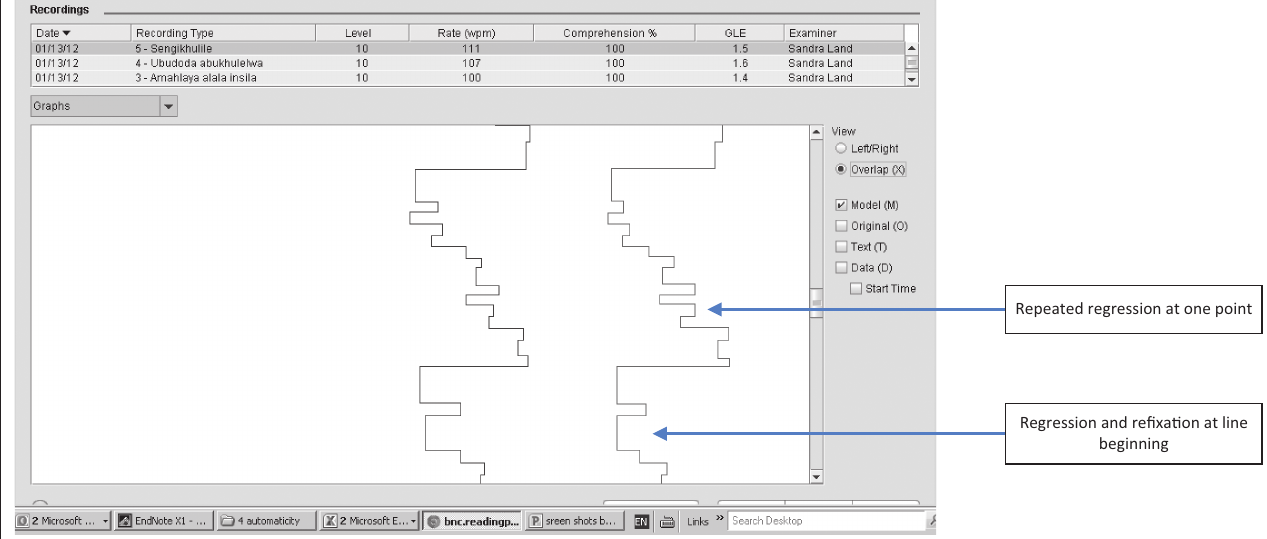
beginningRepeated regression at one point